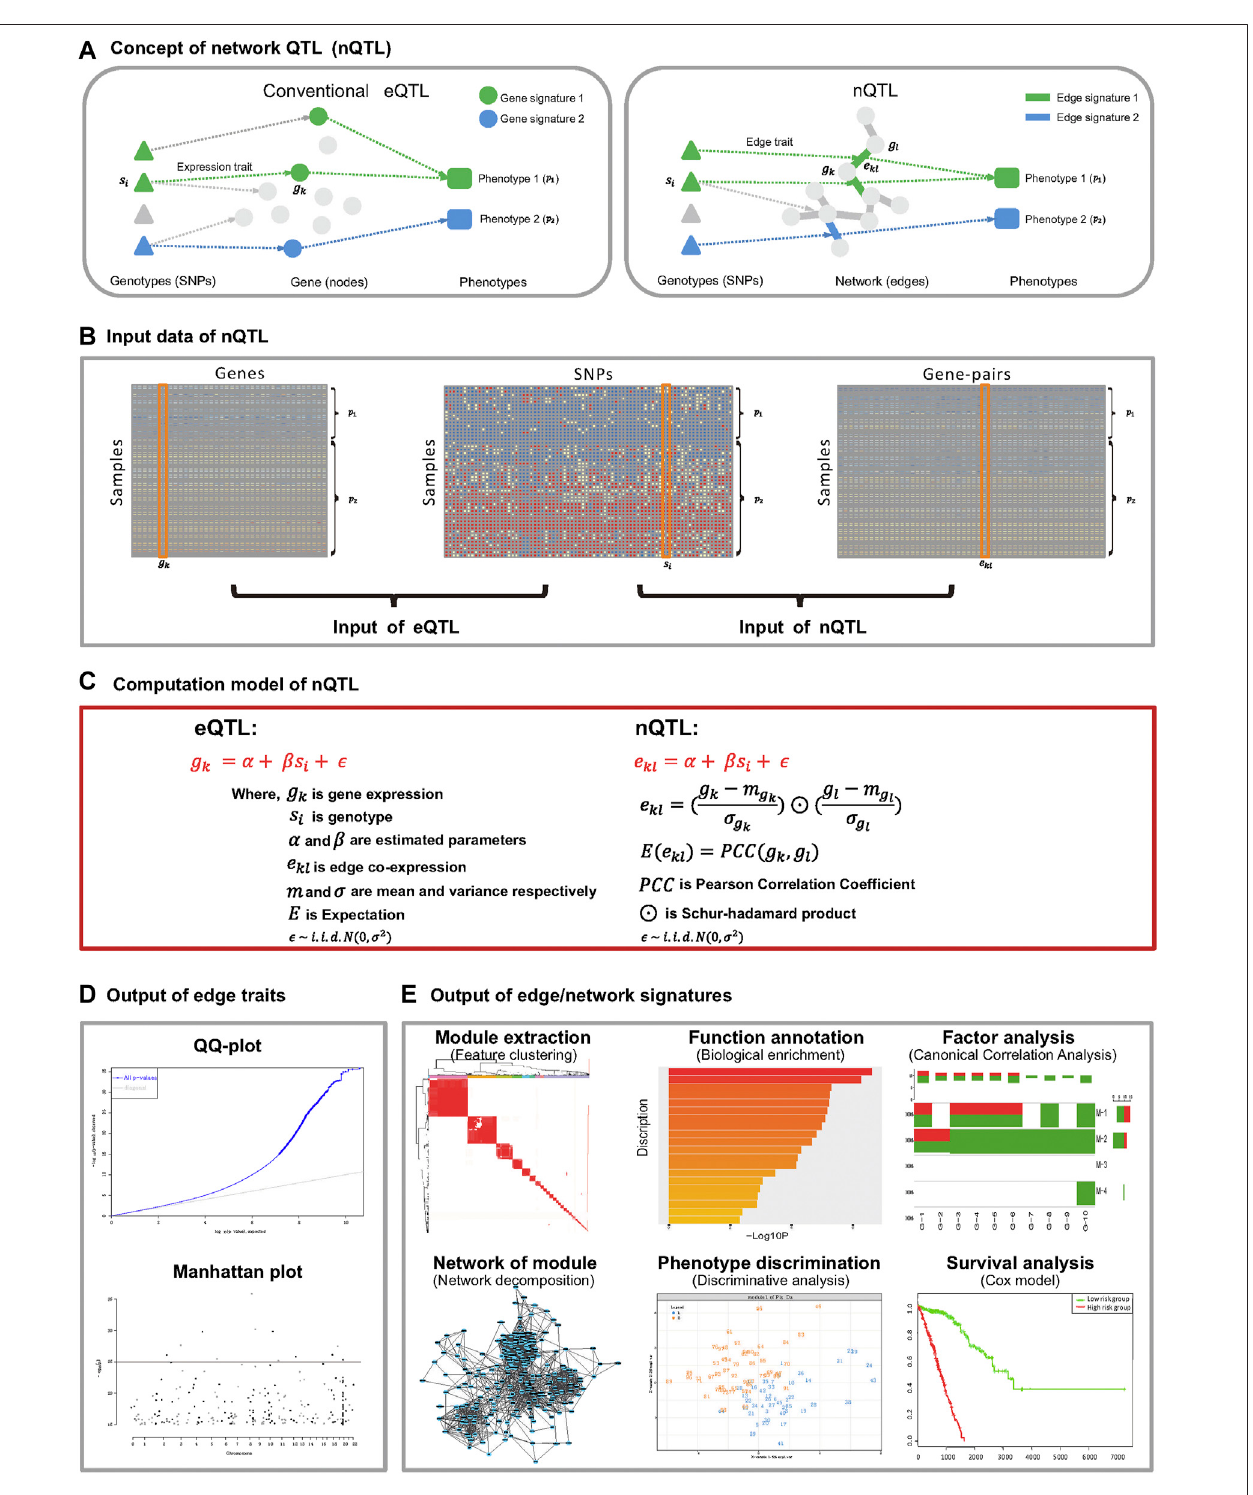
FIGURE 1 | Flow chart of the nQTL framework. It includes upstream nQTL identi fi cation and downstream biological and biomedical signi fi cance analyses of nQTL gene, network, and module. (A) Concept of nQTL compared to conventional eQTL. (B) Organization of input data for eQTL and nQTL analyses. (C) Computational modelforeQTLandnQTLanalyses. (D) TheoutputofnQTLanalysisasanetworktrait,whichisdifferentfromtheconventionalexpression/genetraitofeQTLanalysis. (E) Downstream output of network signatures in the nQTL analysis framework, including nQTL module identi fi cation, biological enrichment of module, correlation between module and relevant factors, network structure of module, discriminative model, and Cox model based on the nQTL module.